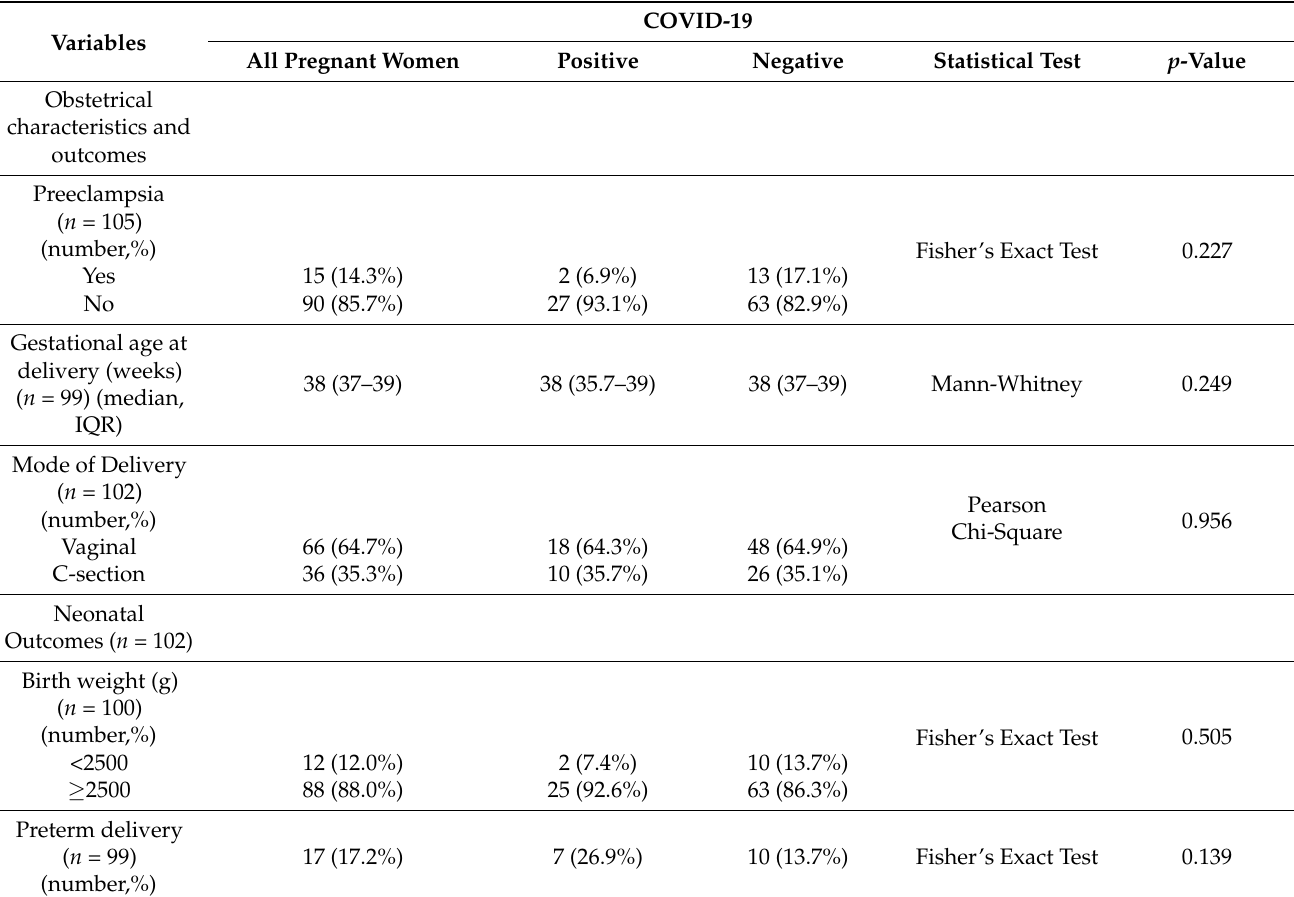
Table 3. Obstetrical and neonatal